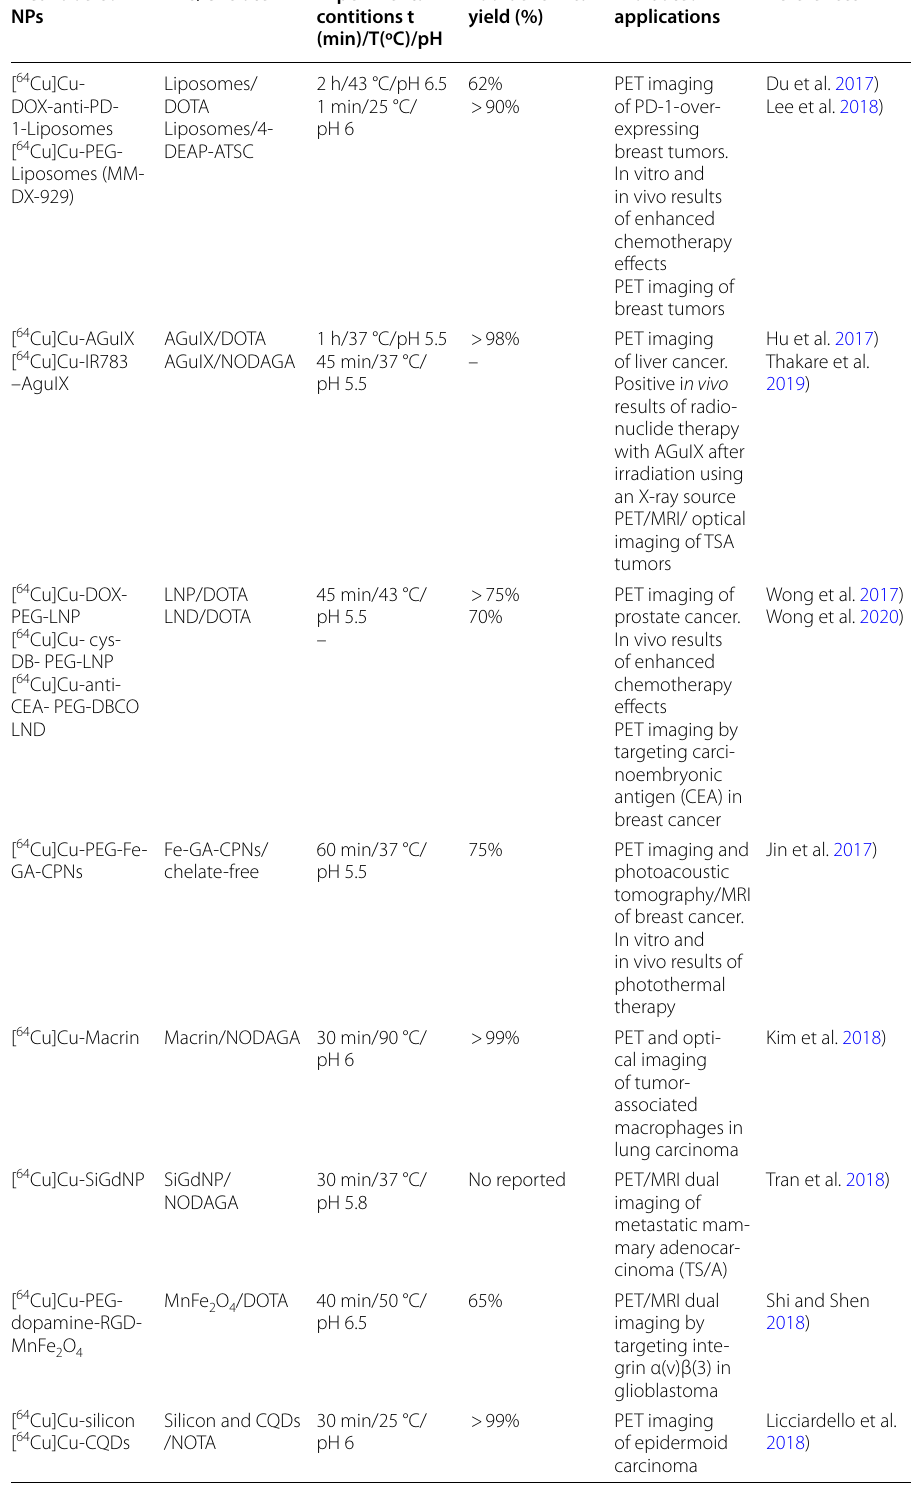
Table 3 Representative studies evaluating 64 Cu‑labeled nanoparticles in preclinical cancer models 64